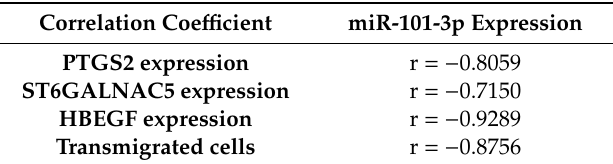
Table 1. Correlation of miR-101-3p expression with PTGS2, ST6GALNAC5 and HBEGF expression, and with the transmigration ability of breast cancer (BC)